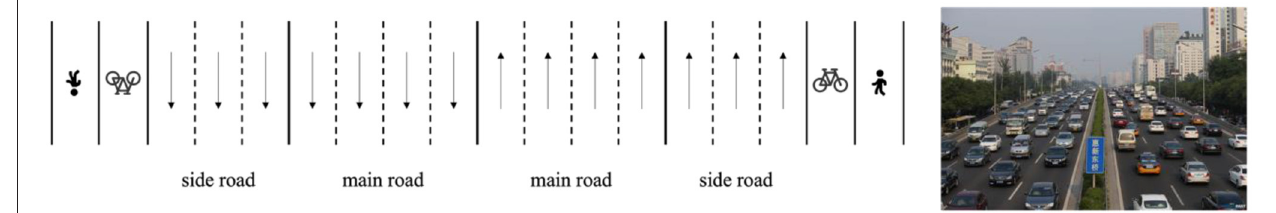
FIGURE 3 | Structure of ring-road.